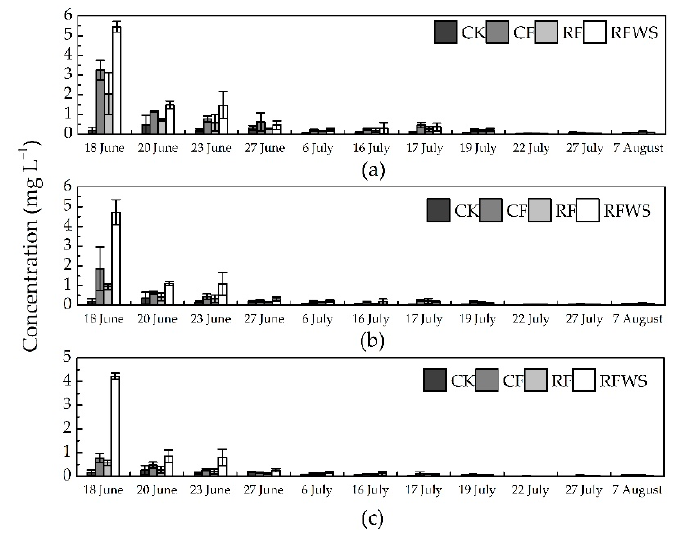
Figure 3. Changes of different forms of P in the overlying water of paddy fields over time under different fertilization treatments. ( a ) total phosphorus (TP); ( b ) total dissolved phosphorus (TDP); ( c ) soluble reactive phosphorus (SRP). Table 2. The average concentration of different forms of P in the overlying water (mg L − 1 ). Treatments